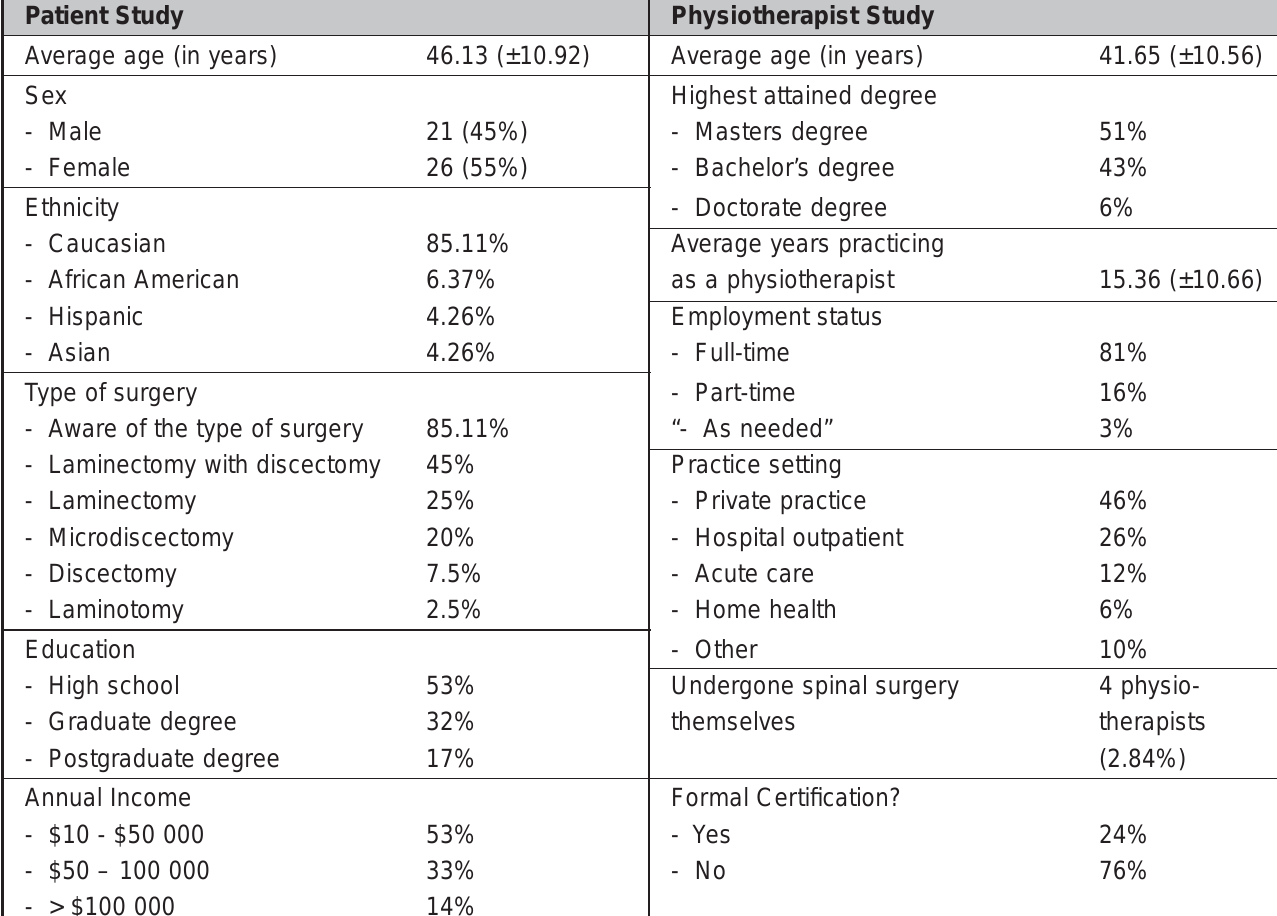
Table 2: Demographic data for the patient and physiotherapist study.